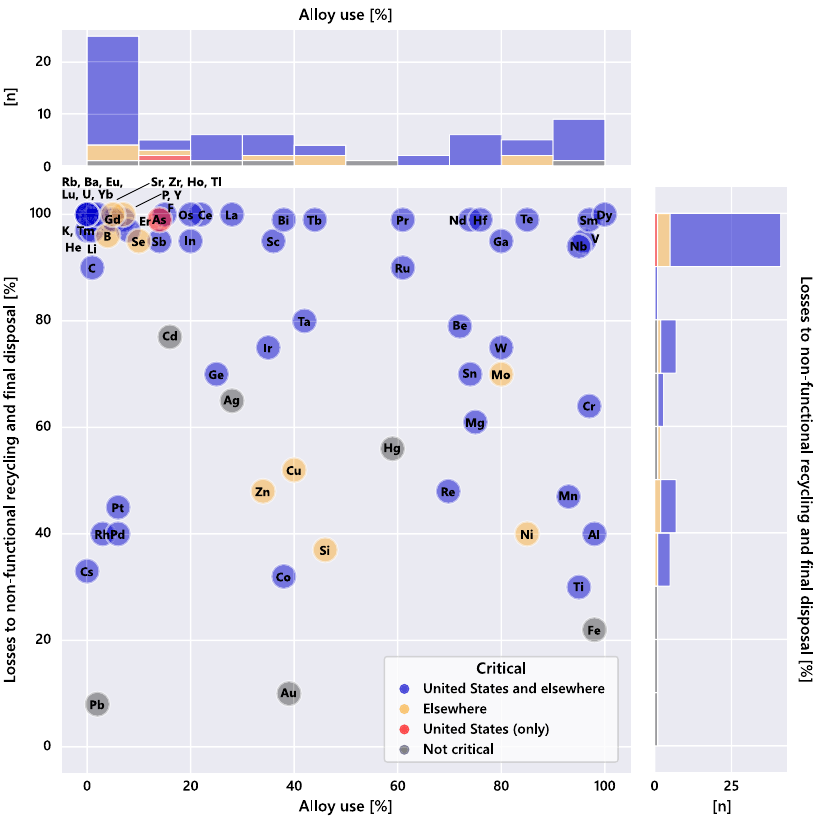
Fig. 5 Losses to nonfunctional recycling and fi nal disposal (i.e., 1 — end-of-life recycling rate) as a function of alloy use for the elements in this analysis. The histogram plots on the top and right side count the number of elements in brackets of